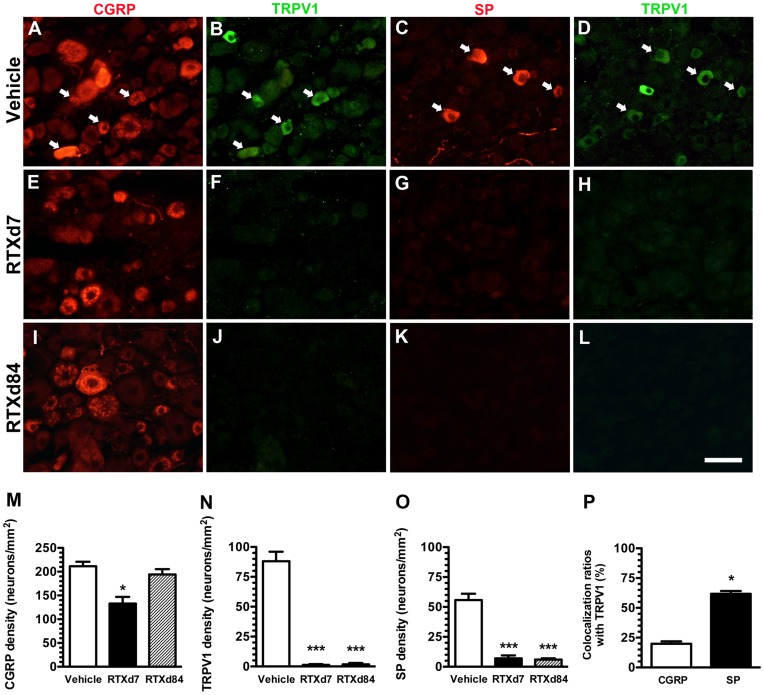
Expression patterns of peptidergic neurons in resiniferatoxin (RTX)-induced neuropathy.Double-labeling immunofluorescent staining was performed with either anti-calcitonin gene-related peptide (CGRP, A, E, I, in red) or anti-substance P (SP) (C, G, K, in red) and anti-transient receptor potential vanilloid subtype 1 (TRPV1; B, F, J, D, H, L, in green) antisera in the vehicle group (A–D) and on RTX-treatment day 7 (RTXd7) (E–H) and RTXd84 (I–L). (A–D) Some CGRP(+) neurons (A) were co-localized with TRPV1(+) neurons (B) (arrow in A and B). SP(+) and TRPV1(+) neurons (C vs. D) were highly co-localized (arrow in C and D) in the vehicle group. (E–H) CGRP(+) neurons were mild reduced (E), whereas SP(+) (G) and TRPV1(+) neurons (F, H) were completely depleted on RTXd7. (I–L) The abundance of CGRP(+) neurons was nearly normalized (I), but depletion of SP(+) (K) and TRPV1(+) neurons (J, L) remained on RTXd84. (M–O) Densities of CGRP(+) (M), TRPV1(+) (N) and SP(+) (O) neurons were quantified accordingly: vehicle group (open bars, n = 5), RTXd7 (filled bars, n = 5), and RTXd84 (gray bars, n = 5). (P) The figure compares co-localization ratios of TRPV1/CGRP (open bars, n = 5) and TRPV1/SP neurons (filled bars, n = 5). Bar, 50 µm; *p<0.05, **p<0.01, ***p<0.001.